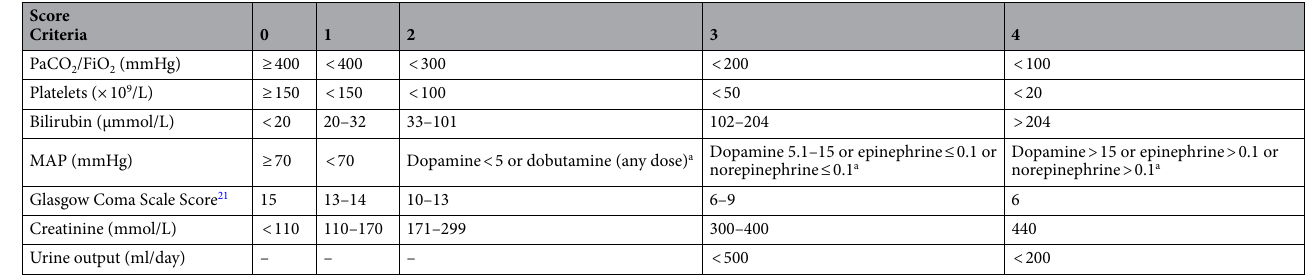
Table 1. Sequential (sepsis-related) organ failure assessment score 3,18 . PaO2 partial pressure of oxygen, FIO2 fraction of inspired oxygen, MAP mean arterial pressure. a Catecholamine doses are given as μg/(kg min) for at least 1 h.